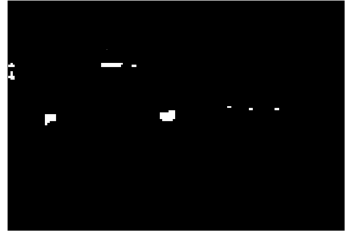
Figure 8. Grayscale adaptive threshold segmentation results in HSV space.